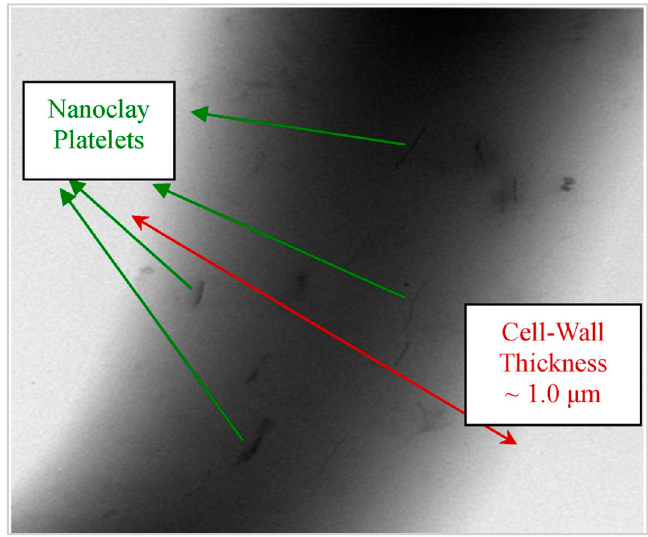
Figure 35. TEM image of a cell wall in foamed PLA-1CN showing the alignment of nanoclay platelets along a cell wall. Reprinted from Nofar [113]. Copyright (2020), with permission from Elsevier.